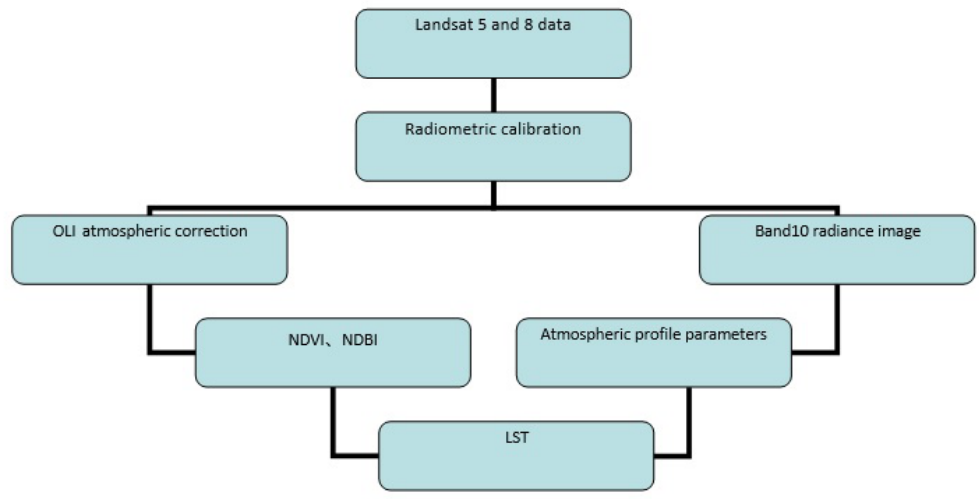
Fig. 1 Workflow of some index of heat